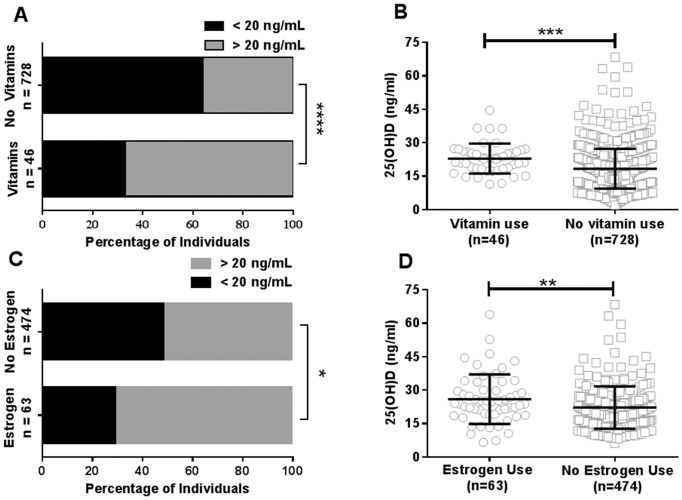
Vitamin usage and estrogen supplementation are associated with increased vitamin D levels.(A) Percentage of individuals that reported taking vitamins or not taking vitamins with 25(OH)D levels <20 ng/mL or >20 ng/mL. ****p<0.0001, Fisher's exact test. (B) Levels of 25(OH)D observed in individuals with self-reported vitamin use (n = 46) or no vitamin use (n = 728). Median 25(OH)D levels with interquartile range is shown. ***p<0.001, Mann Whitney test; p<0.05, Shapiro-Wilk and D'Agostino normality test. (C) Percentage of European-American female study participants that reported estrogen supplementation. *p<0.05, Fisher's exact test. (D) Levels of 25(OH)D in European-American female study participants with self-reported estrogen supplementation (n = 63) or no estrogen supplementation (n = 474). Median vitamin D levels with interquartile range are shown. **p<0.01, Mann Whitney test; p<0.05, Shapiro-Wilk and D'Agostino normality test.